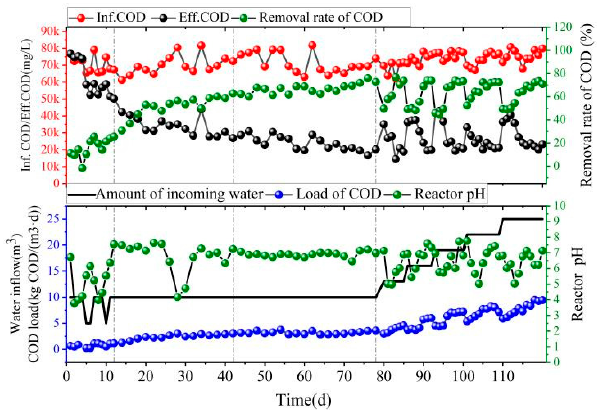
Figure 2. EGSB anaerobic segment operating parameters.